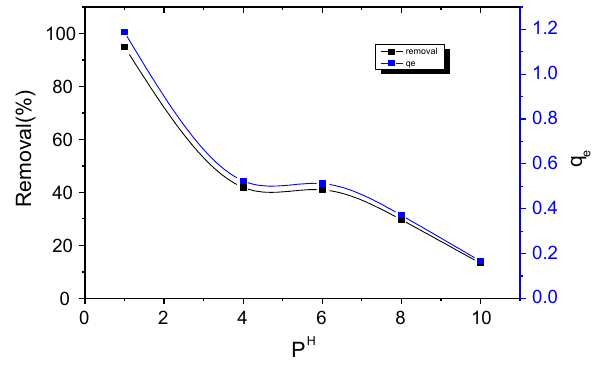
Fig. 7 Effect of pH